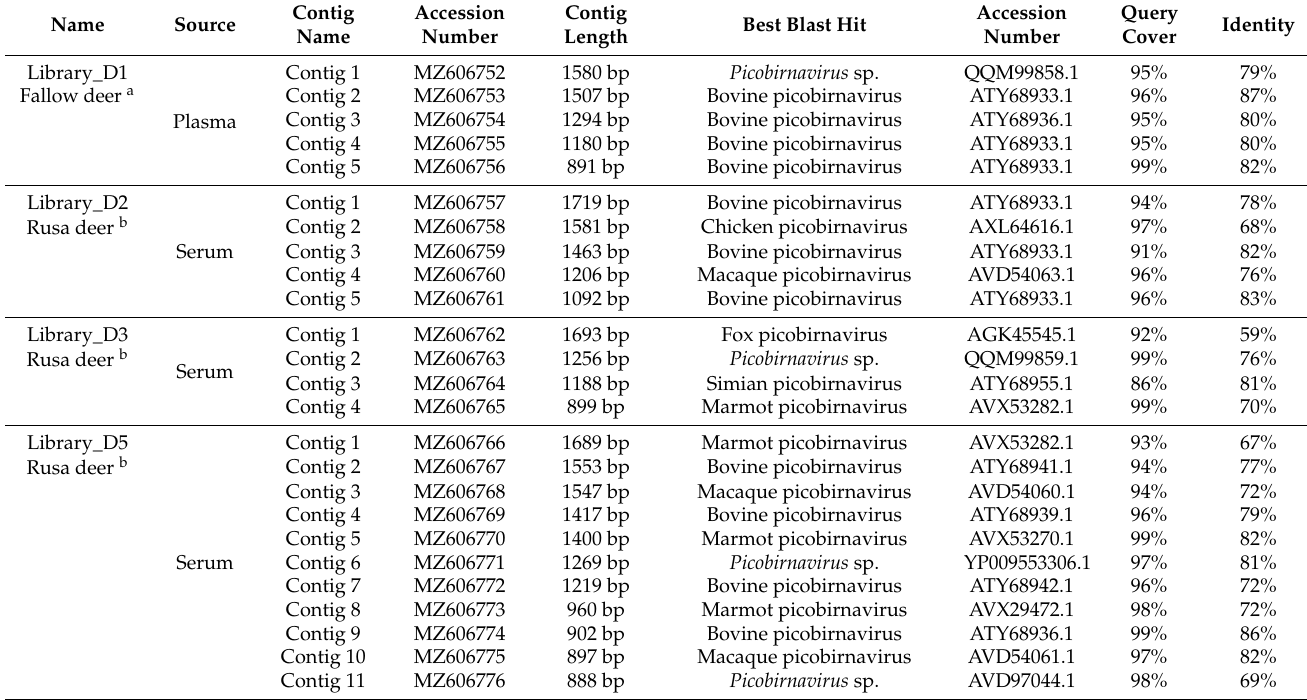
Table 1. Summary of sequences matching to PBV strains in barcoded libraries of deer